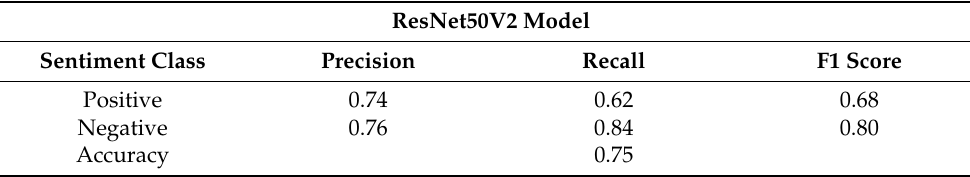
Table 7. Performance metrics of the ResNet50V2 model for image sentiment